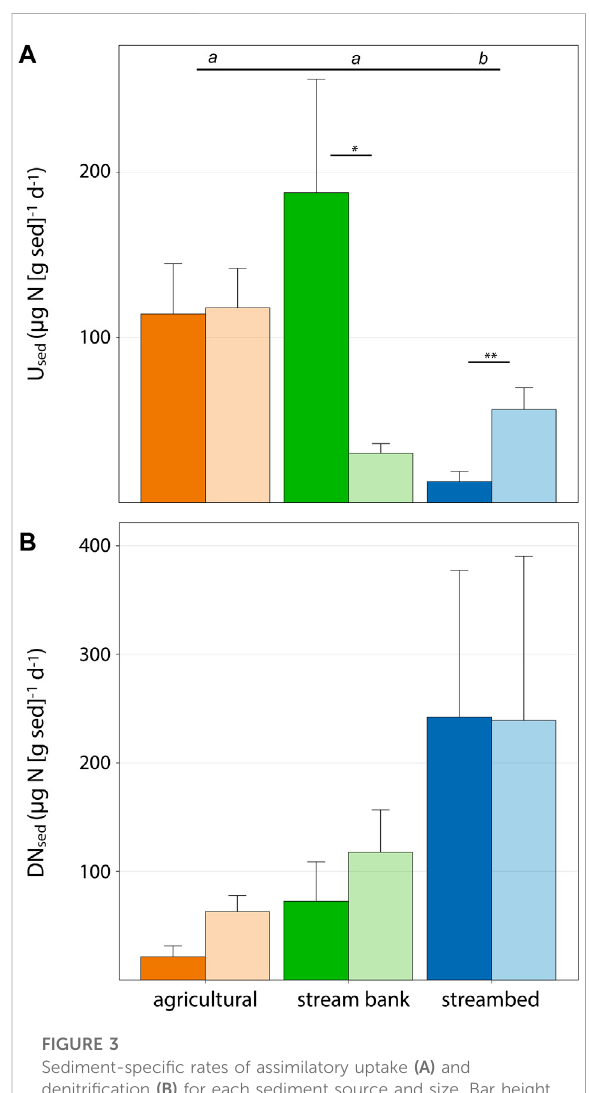
FIGURE 3 Sediment-speci fi c rates of assimilatory uptake (A) and denitri fi cation (B) for each sediment source and size. Bar height and error bars correspond to mean and SEM values, respectively ( N = 12). Color legend is consistent with Figure 2. Size fractions are represented in dark and light colors for sand and silt/ clay, respectively. Among sediment sources, bars with unique letters onthetopofeach panel aresigni fi cantly different(unpaired Wilcoxon tests following signi fi cant Kruskal – Wallis). Within each sediment source, signi fi cantly different values between size fractions are indicated as: [blank] p > 0.05; * p < 0.05; **, p < 0.01; *** p <